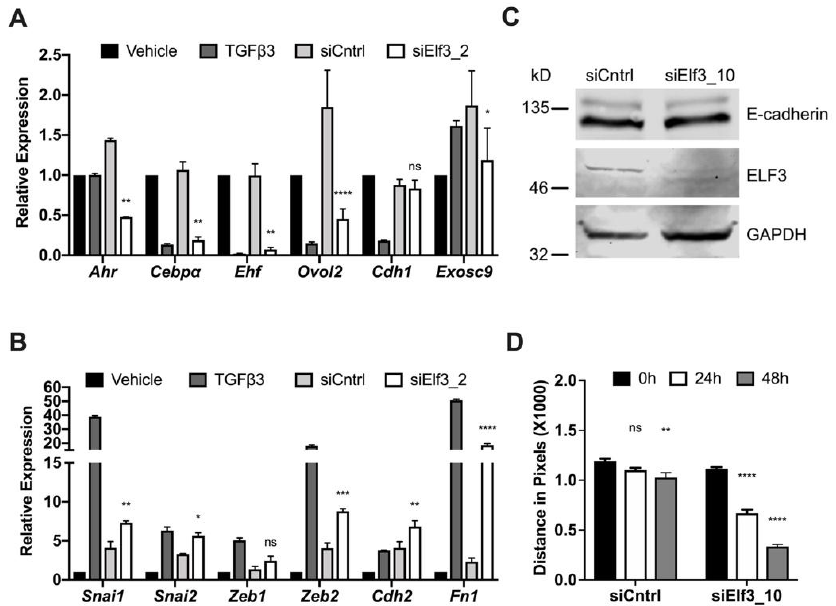
Figure 3. Loss of Elf3 preserves the mesenchymal state. NMuMG cells recovering from TGFβ3 treatment were transfected with either control or Elf3 targeting siRNA, after 72 h, cells were collected, RNA was isolated, and changes in gene expression were measured by qPCR for EMT / MET relevant genes ( A ) and mesenchymal markers ( B ). ( C ) Immunoblot showing ELF3 and E-cadherin protein levels in response to Elf3 silencing by siRNAs. ( D ) Summary of the wound healing assay results following Elf3 silencing measured as the distance between the edges of migrating cells. Results represent the averages of at least three independent experiments in triplicates. Paired Student’s t -test was used to calculate statistical significance. * p -value < 0.05; ** p -value < 0.01; *** p -value < 0.001; **** p -value < 0.0001.